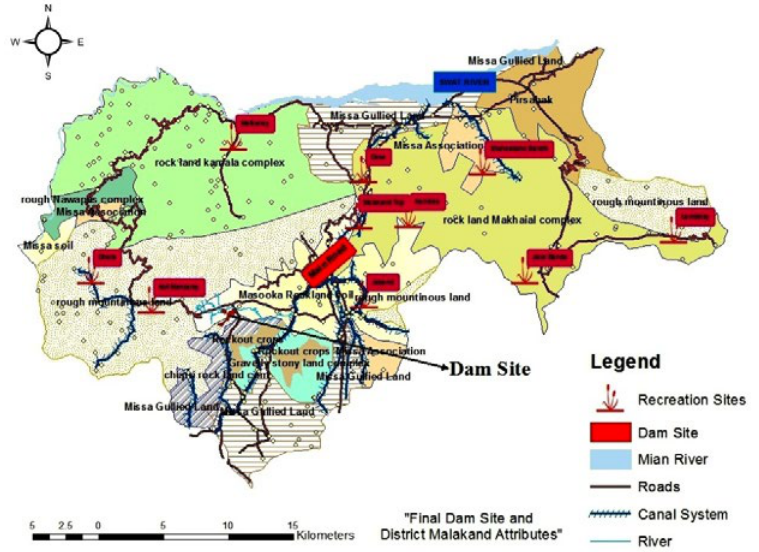
Fig. 13. Final dam site Fig. 13: Final dam site selection